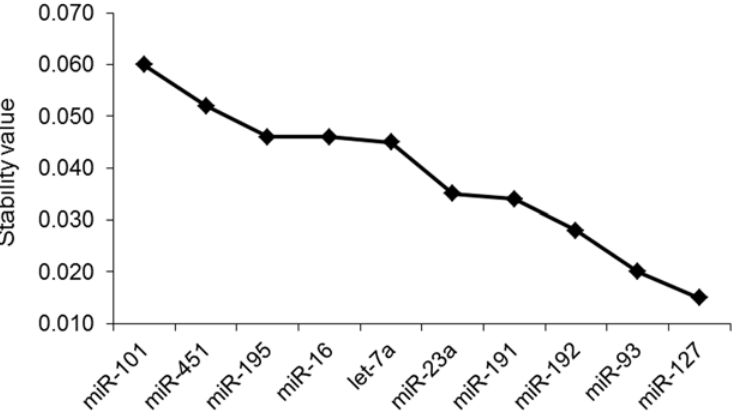
Fig 3. Stability values of each reference miRNA from the NormFinder algorithm. Ranking of candidate reference genes based on stability values calculated by NormFinder.